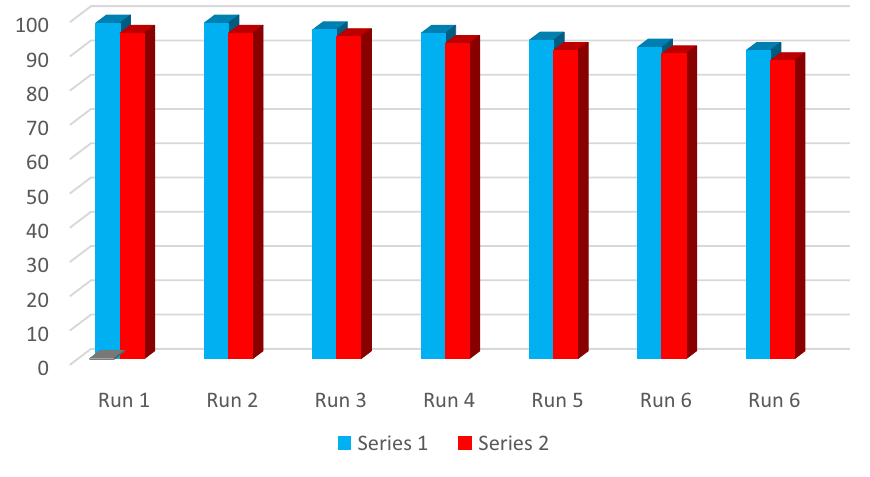
Figure 11. Reusability of Fe 3 O 4 -g-C 3 N 4